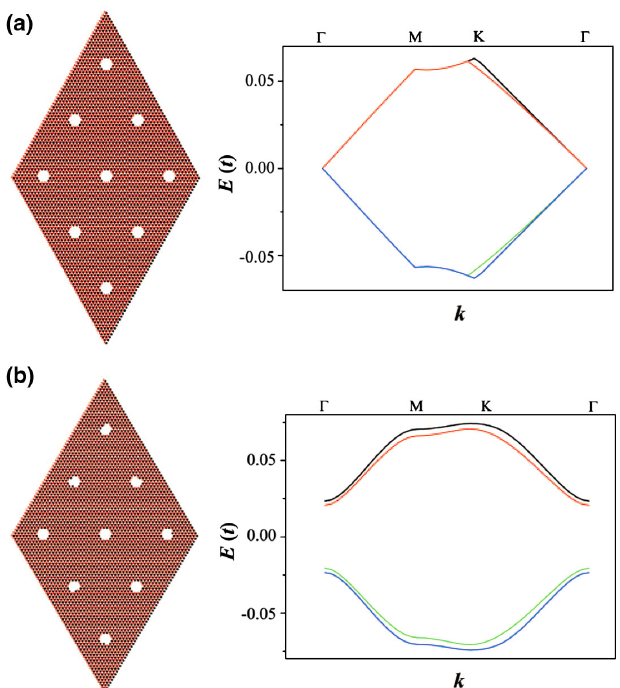
FIG. 5. ffiffiffi p 3 a . In diagram (a), we have an antidot lattice given by 19 atomic scale. We can see that there is no band gap, as predicted. reappears, accompanied by a small energy splitting for both the conduction and valence bands are